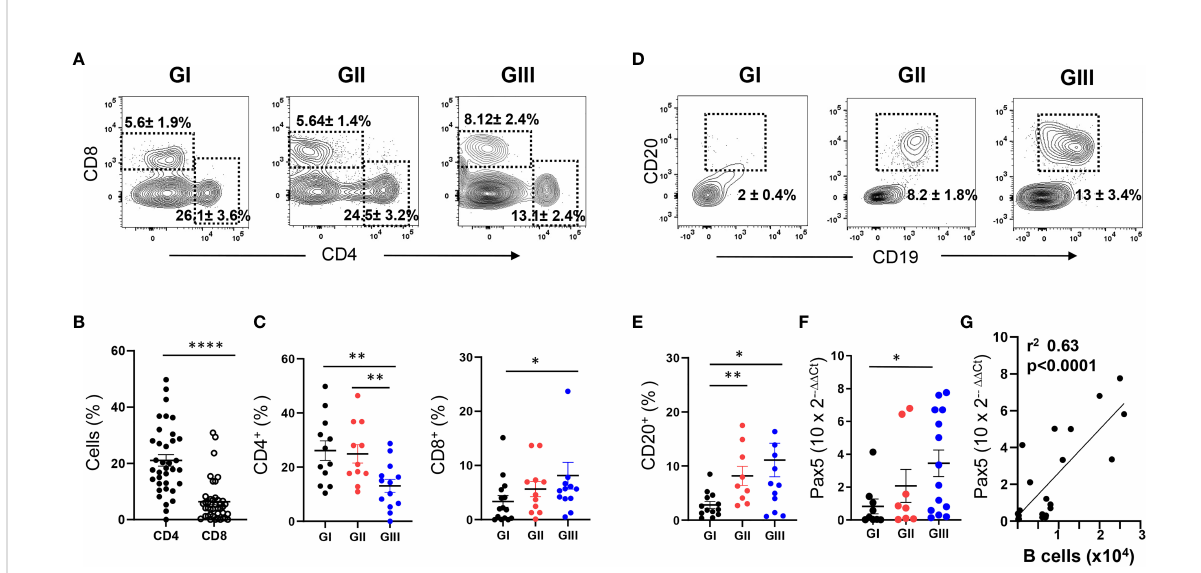
FIGURE 5 Age-dependent increase of T and B lymphocytes in NLF samples from bronchiolitis patients. Flow cytometry was performed on NLF bronchiolitis samples (n = 38) stained with anti-CD4, anti-CD8, anti-CD19 and anti-CD20 MonAbs. Quanti fi cations were done on the lymphoid gate described in Figure 4. Frequency of subpopulations relative to CD45 + cells in this gate are shown. (A) Representative contour plots from GI-GIII NLF samples displaying the staining with anti-CD8 and anti-CD4 by fl ow cytometry. The dotted rectangles inside the plots indicate CD4 + and CD8 + T lymphocytes, and the numbers are the %, mean ± SEM of CD4 + and CD8 + cells. (B) Frequency of CD4 + and CD8 + cells in all NLF samples analyzed. (C) Frequency of CD4 + and CD8 + cells in NLF samples from GI (n = 15), GII (n = 10) and GIII (n = 13) children. (D) Representative contour plots displaying the staining with anti-CD20 and anti-CD19 to identify CD19 + CD20 + B lymphocytes by fl ow cytometry. Relative numbers of B cells (%, mean ± SEM) are indicated inside the plots. (E) Frequency of B cell numbers in NLF samples from GI (n = 12), GII (n = 11) and GIII (n = 13). (F) Relative expression of PAX5 determined by RT-qPCR in NLF samples from GI (n = 9), GII (n = 8), GIII (n = 12). The amount of Pax5 transcripts was calculated as the 2 − DD CT relative to that of GAPDH and relative to adult PBMC values, performed in duplicates. (G) Linear regression of Pax5 2 − DD CT data and the number of CD20 + cells in NLF samples. In the graphs from panels (B, C and E – G) each dot represents an individual sample and the mean ± SEM is also shown. Comparisons among groups were done using non-parametric